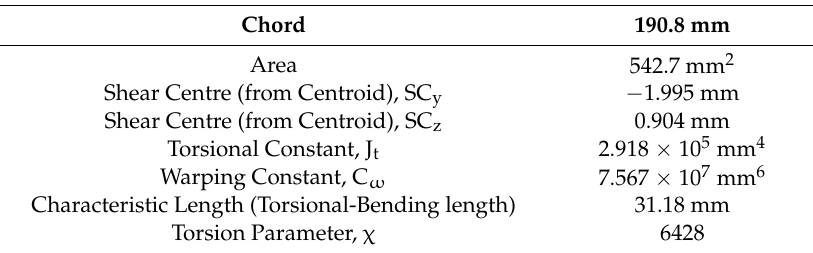
Table 2. Data of the Outer Trailing-edge mean geometric